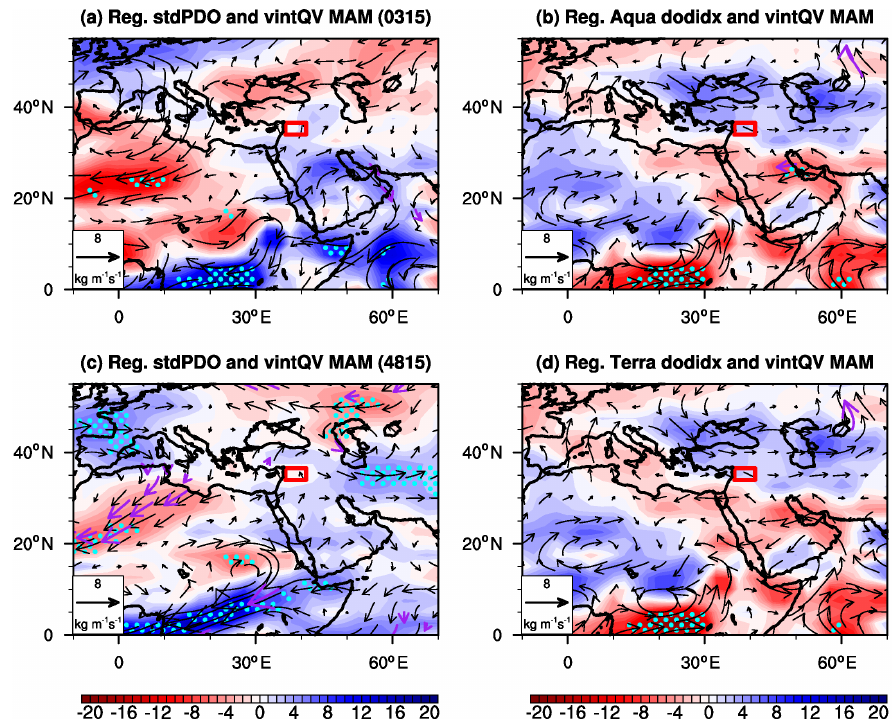
Figure 8. Regression of vertically integrated mass weighted monthly moisture flux (vectors; kgm − 1 s − 1 ) and its magnitude (shading) onto standardized PDO index during (a) 2003–2015 and (c) 1948–2015, and onto the standardized (b) Aqua and (d) Terra DOD indices. Moisture flux is integrated from surface to 300hPa. Areas with magnitude of moisture flux significant at the 90% confidence level are dotted, and moisture fluxes significant at the 90% confidence level are plotted in purple vectors ( t